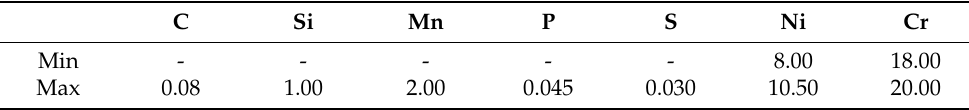
Table 1. Chemical composition thin metal foils of SUS 304 (wt%).